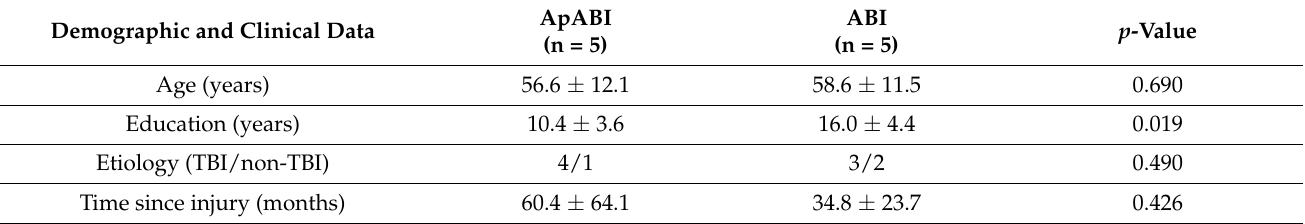
Table 1. Clinical and demographic data of